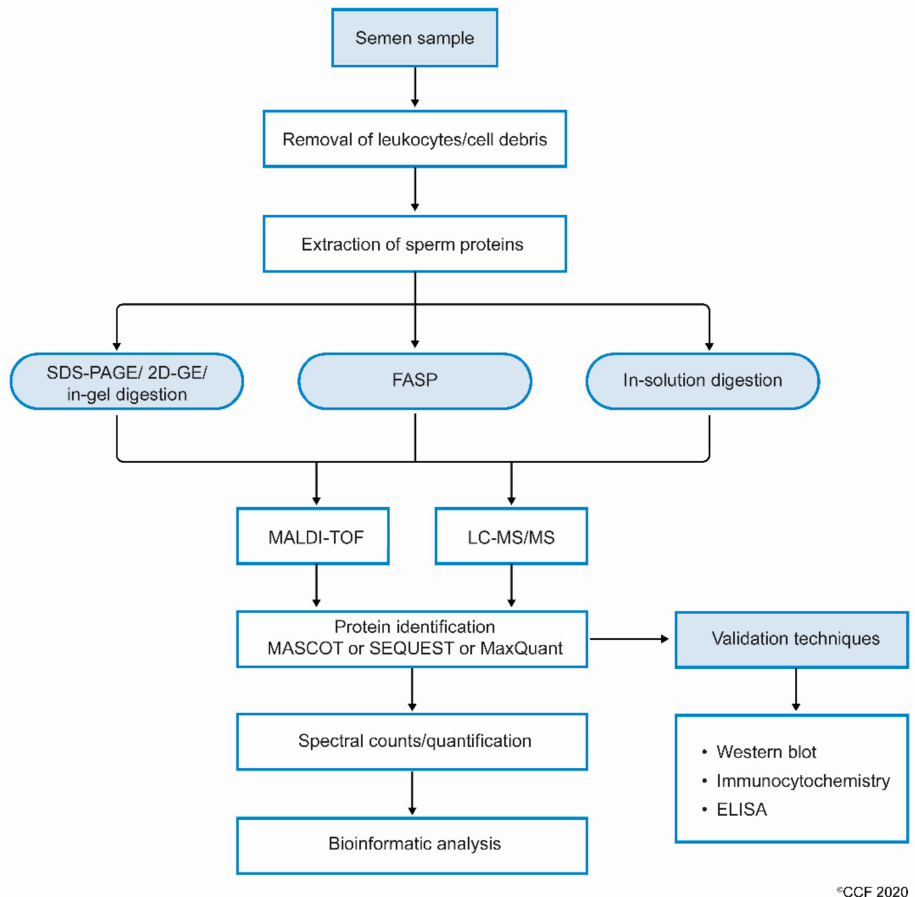
Figure 1. Workflow involving the processing of semen samples for sperm